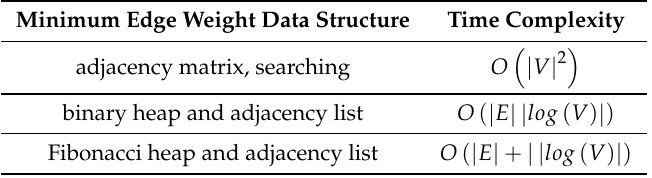
Table 2. Time complexity for Prim’s algorithm using different